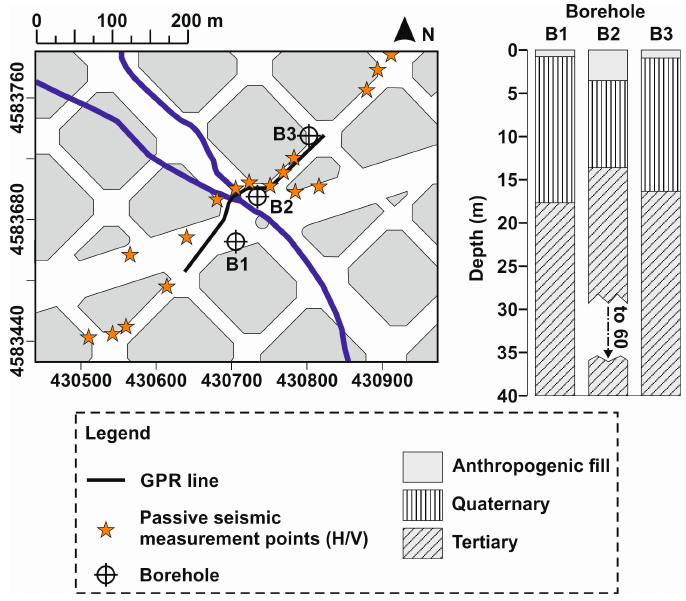
Figure 10. Location of the seasonal underground stream, the GPR line, the passive seismic measurements and the boreholes.